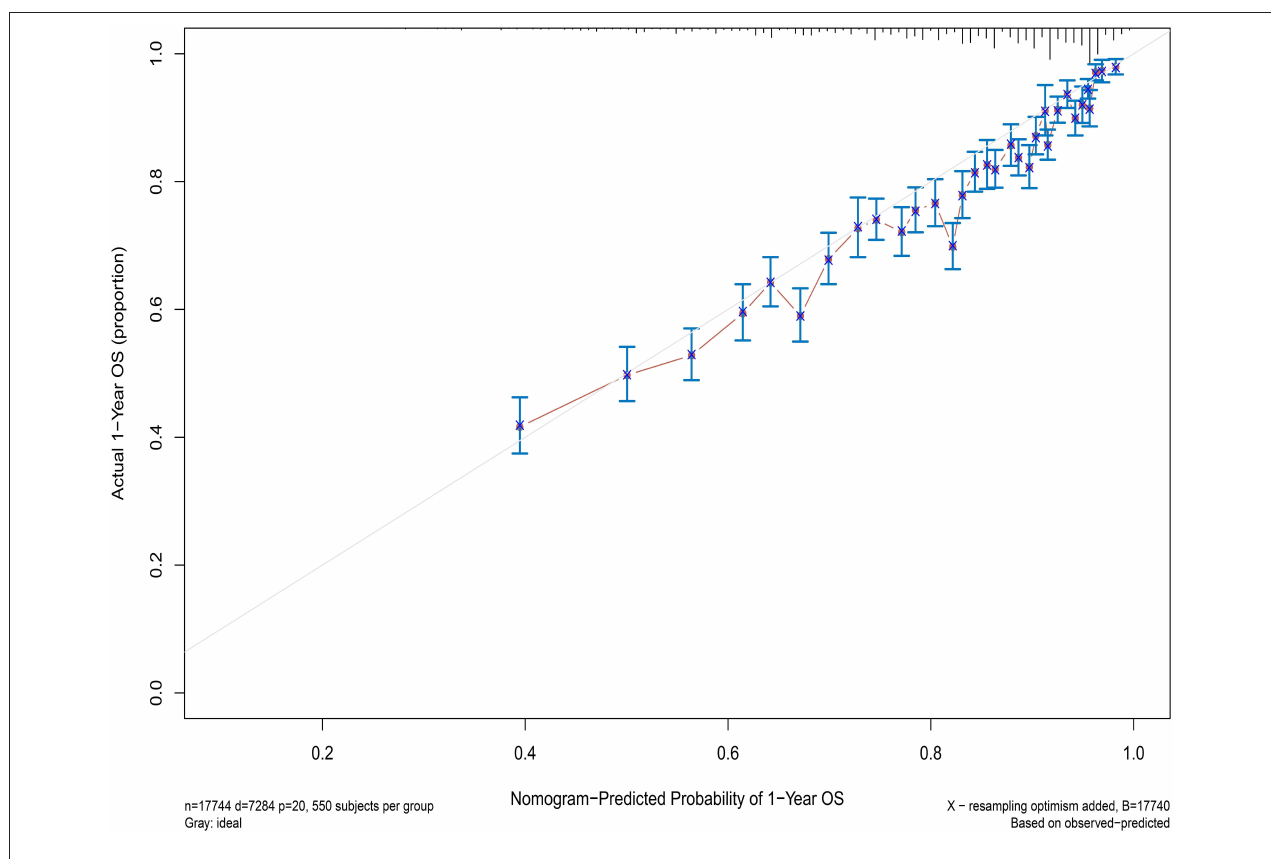
FIGURE 9 | The calibration curves for predictions of overall survival at 1 year after diagnosis.